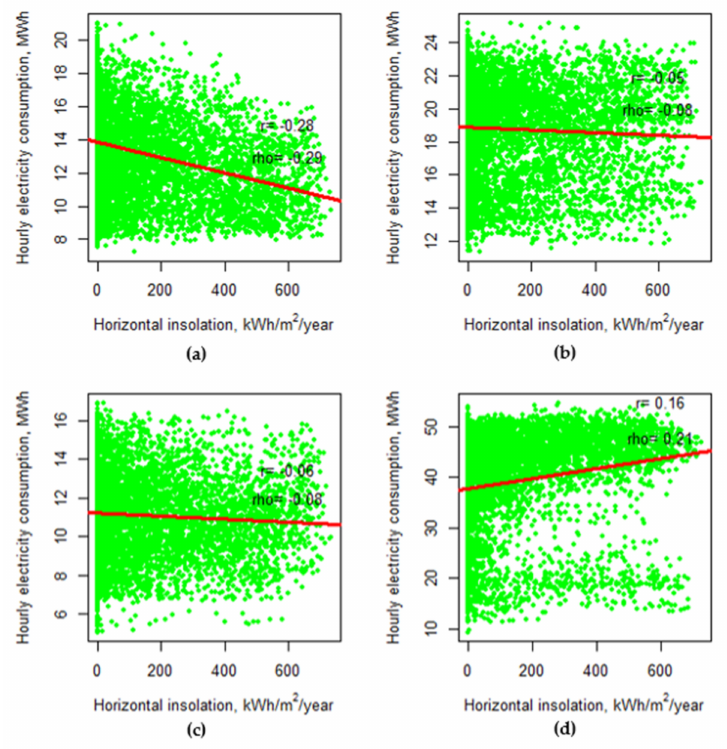
Figure 15. Correlation between the hourly values of horizontal insolation and electricity consumption for the analyzed case of the research objects: ( a ) M1, ( b ) M2, ( c ) M3 and ( d ) M4. Source: own study in the RStudio